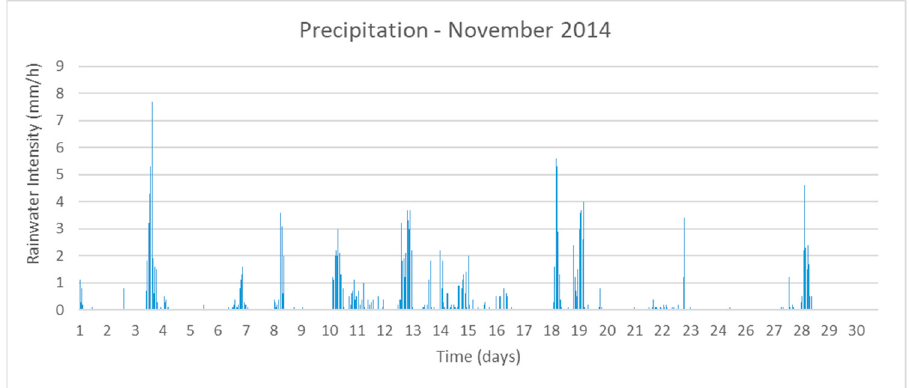
Figure 3. Precipitation records in November